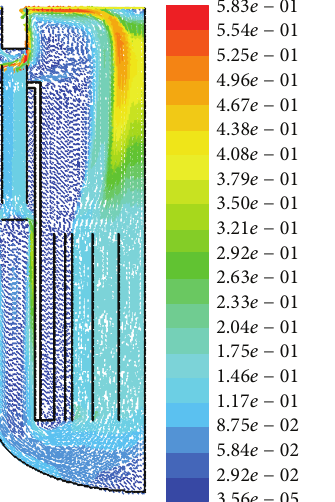
Figure 10: Velocity distribution of SNRLFR-100 primary cooling system.